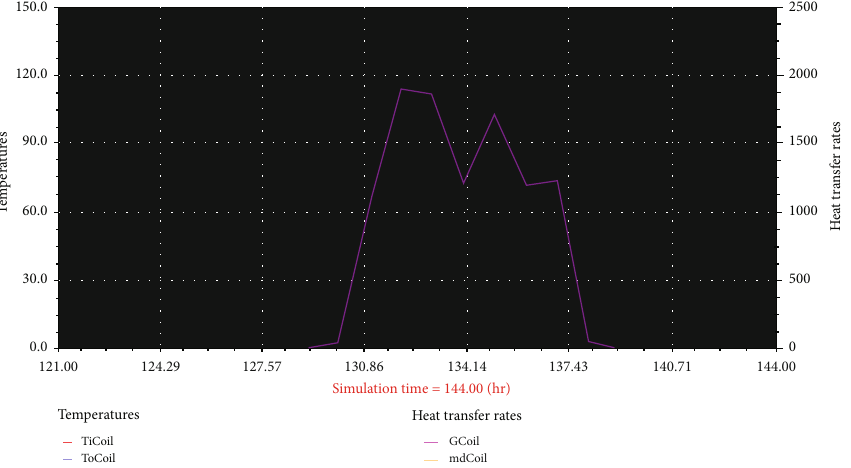
Figure 15: Thermal energy generated by the solar water heater system on January 4.